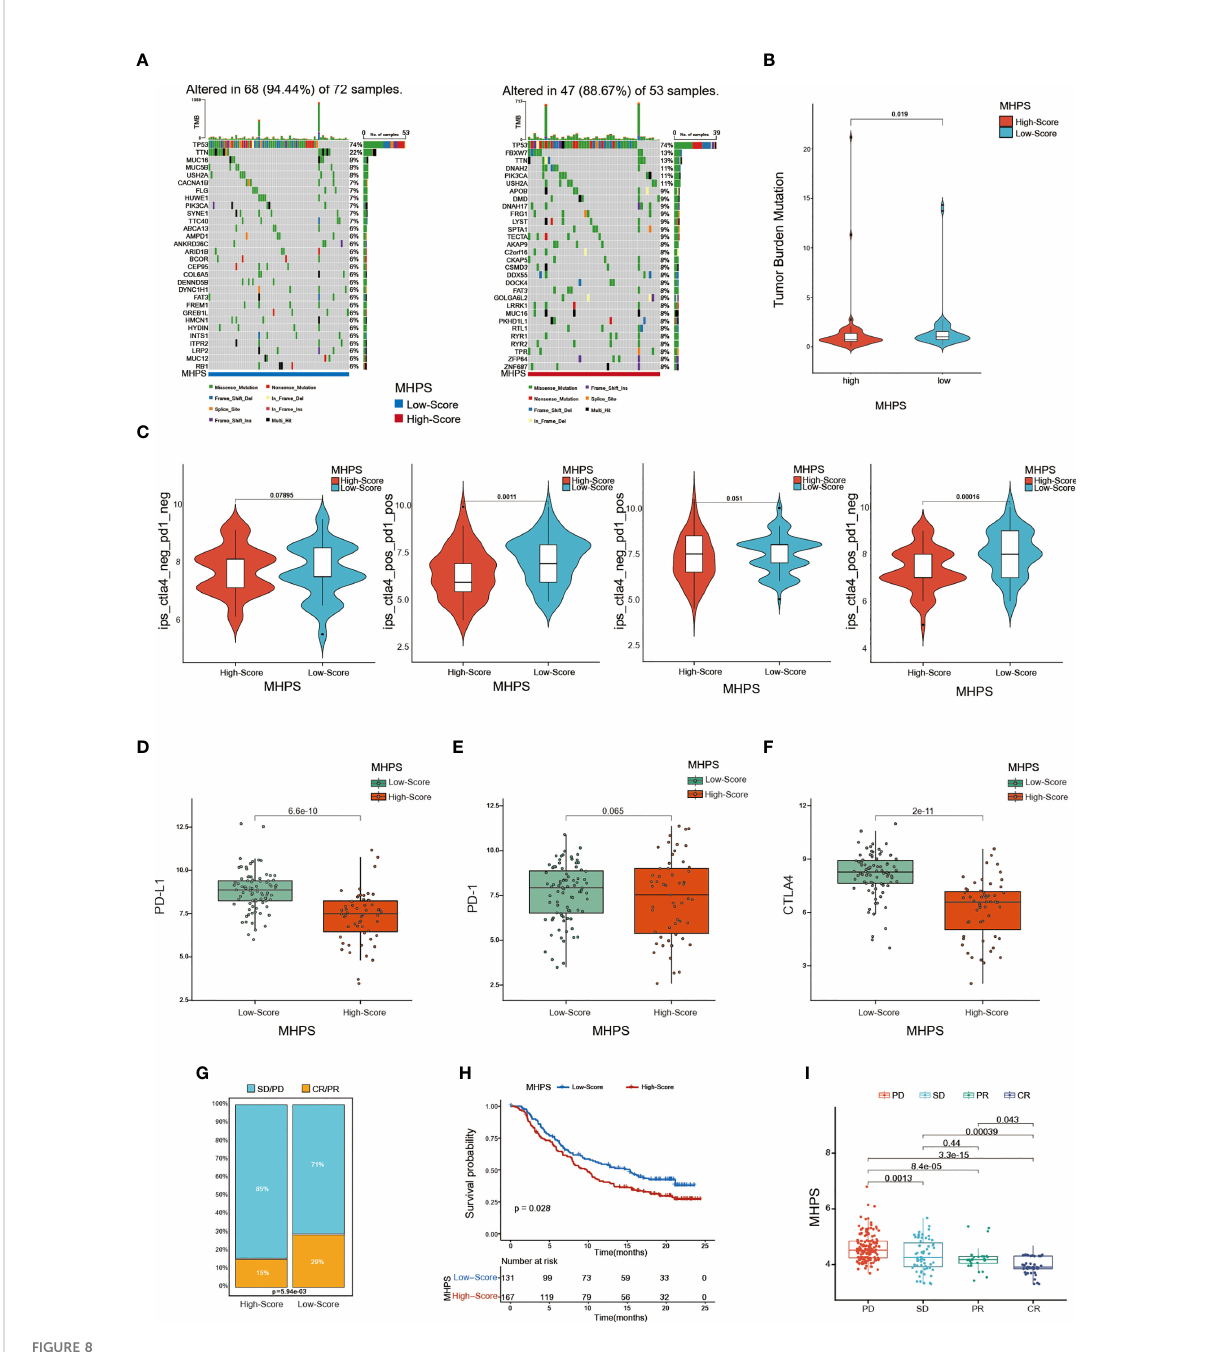
FIGURE 8 Evaluation of the sensitivity to immunotherapy with MHPS (A) Oncoplot of gene mutations in the low- and high-risk groups. (B) The tumor burden of low- and high-risk groups. (C) Comparison of immunophenoscore (IPS) between low and high MHPS risk groups. (D – F) Expression of PD-1, PD-L1, CTLA-4 in low- and high-risk groups (G) Proportion of immunotherapy responsive and ineffective patients in low- and high-risk groups. SD, stable disease; PD, progressive disease; CR, complete response; PR, partial response. (H) Different overall survival of patients with high or low MHPS score. (I) Comparison of risk score of patients with different immunotherapy